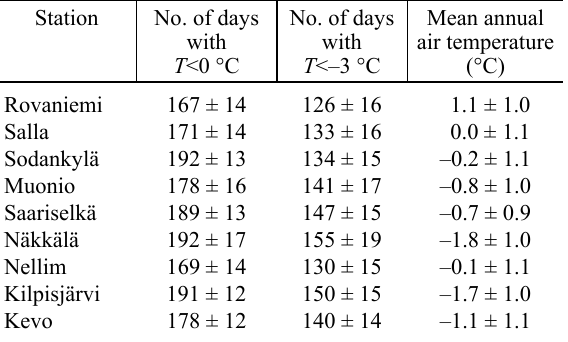
Table 4. Winter duration and mean annual air temperature